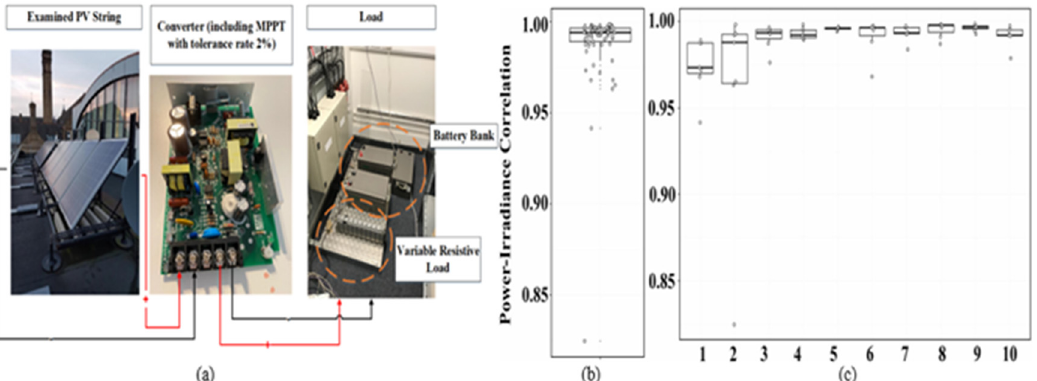
Figure 1. ( a ) Examined PV system; ( b ) distribution of power–irradiance correlation for 70 days; ( c ) distribution of power–irradiance correlation over 10 weeks.